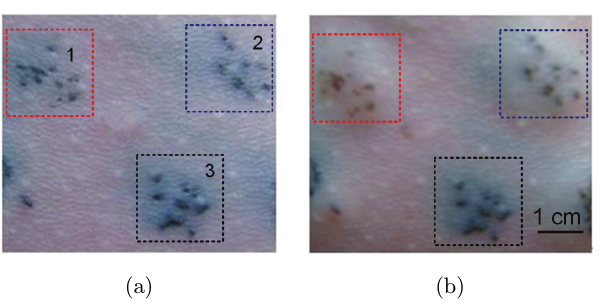
Fig. 2. Quanti¯cation of pigment clearance in tattoo areas with di®erent treatments. PT þ laser: the area treated with OCA of PT then irradiated with Q-switched laser (1064 nm, 60 mJ); Laser: tattoo area treated with single Q-switched laser (1064 nm, 60 mJ); Intact: tattoo area without treatment. Data shown as mean (cid:1) SD ( n ¼